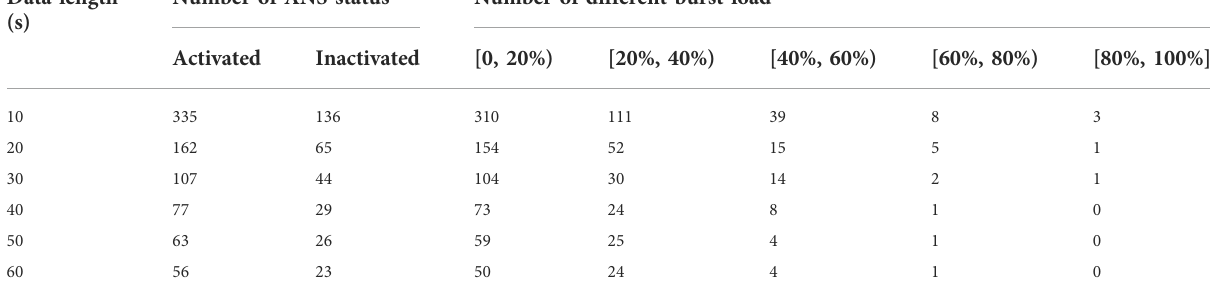
TABLE 1 The number of data segments according to different data length, ANS status and burst load.